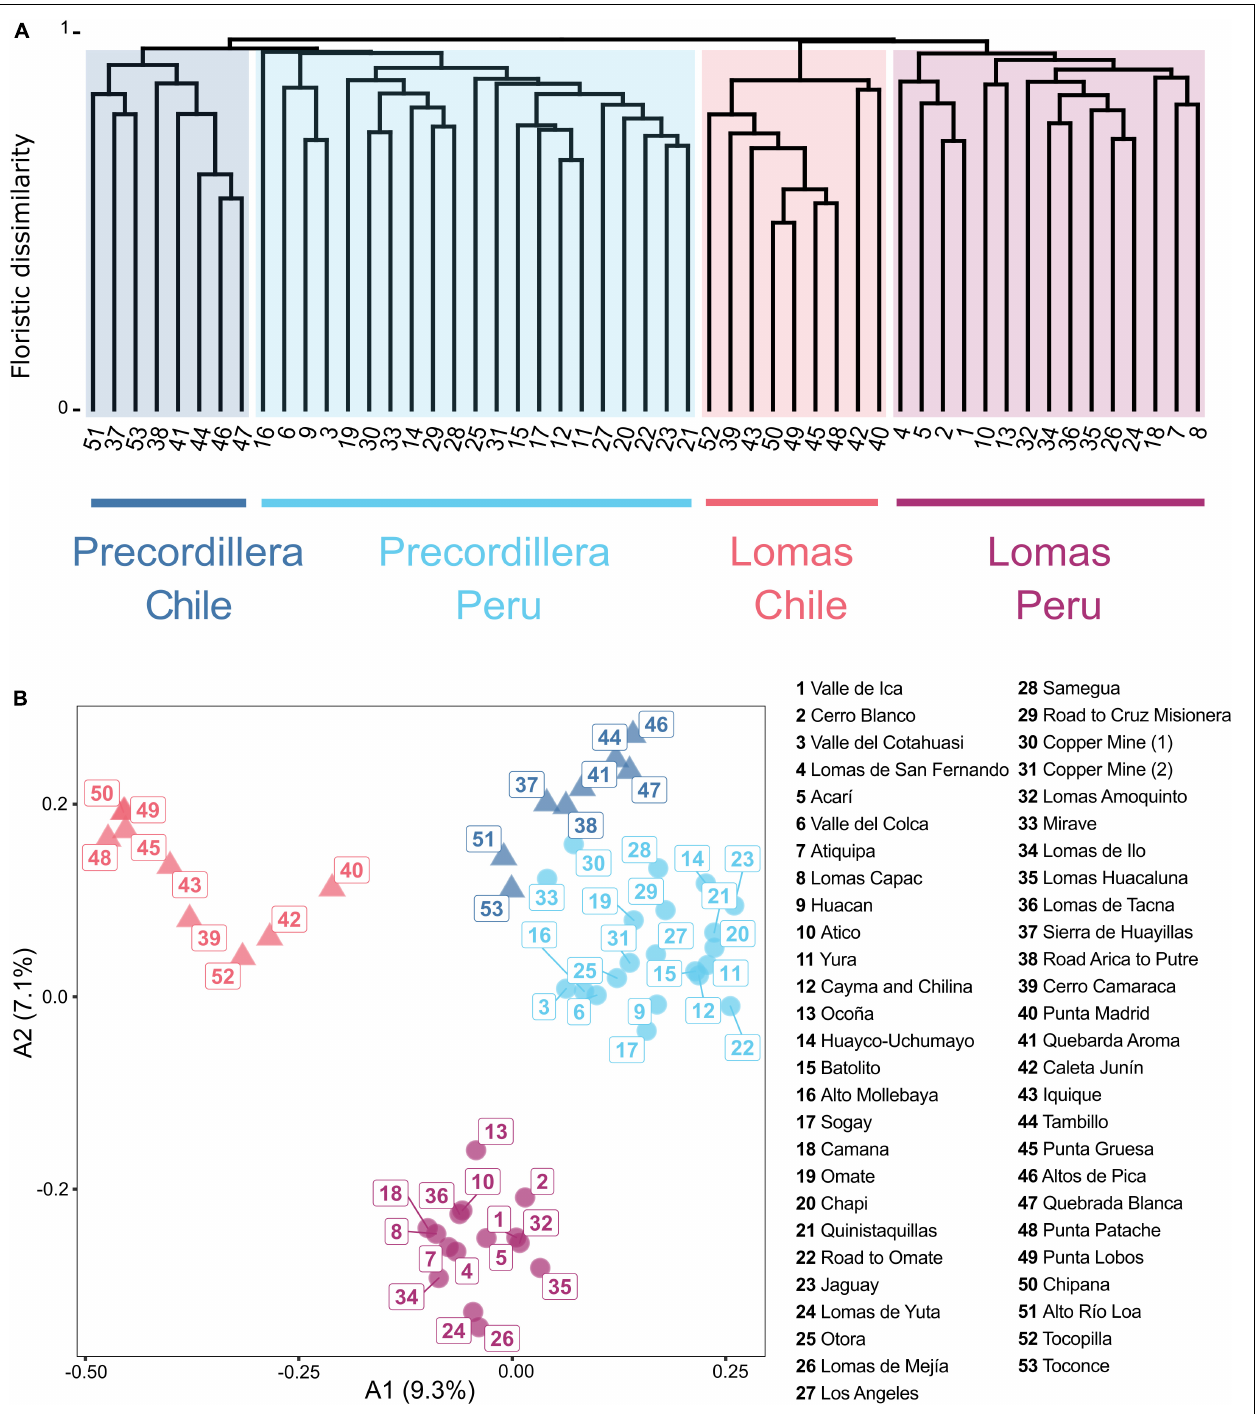
FIGURE 3 | (A) Dendrogram based on cluster analysis of pairwise floristic dissimilarity (Sørensen index) between Peruvian and Chilean desert locations. Clustering is based on UPGMA. Cluster colors code the geographical regions displayed at the bottom. Numbers in square brackets refer to the numbers in the Overview map ( Figure 1 ). (B) Ordination of Peruvian (circle) and Chilean (triangle) desert locations based on pairwise floristic dissimilarities (Sørensen index). X- and y-axis correspond to the first two axes (A1 and A2) of PCoA of floristic data. Values of A1 and A2 indicate proportion of total variance explained by each axis. Colors of locations indicate cluster identities retrieved from cluster analysis related to the geographical region. Separation of the Lomas Peru cluster from the Lomas Chile cluster contrasts with the higher affinities between the Precordillera Chile and the Precordillera Peru cluster.